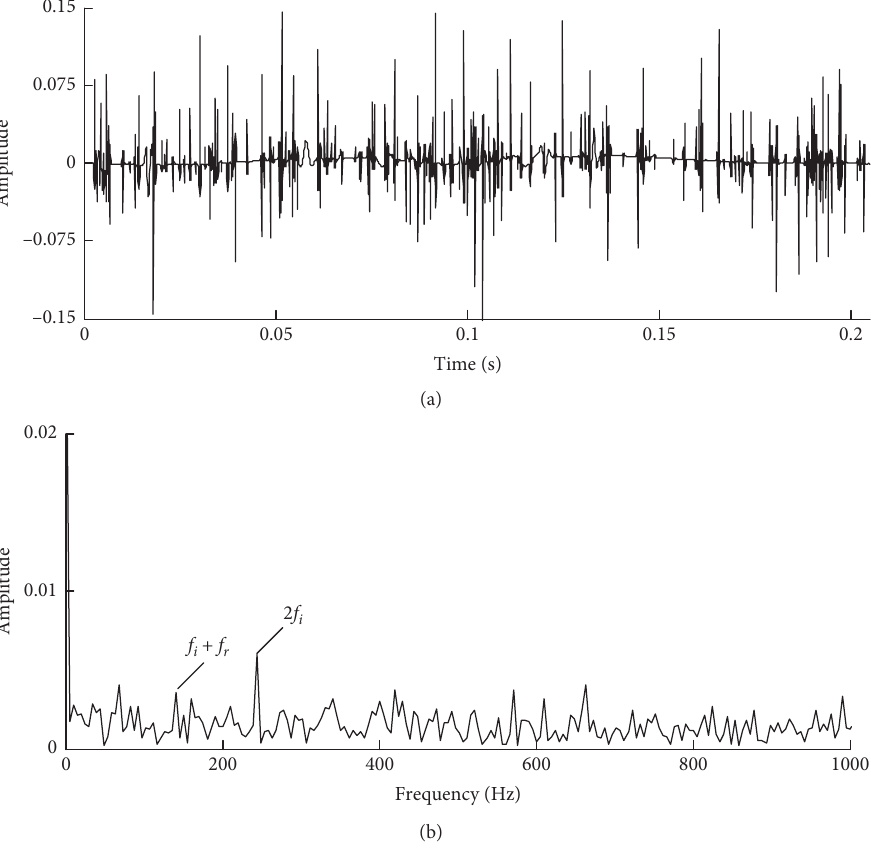
Figure 17: TQWT-SK decomposition result of inner race fault.